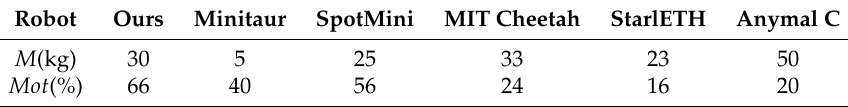
Table 2. Payload capacity comparison of representative motor-driven